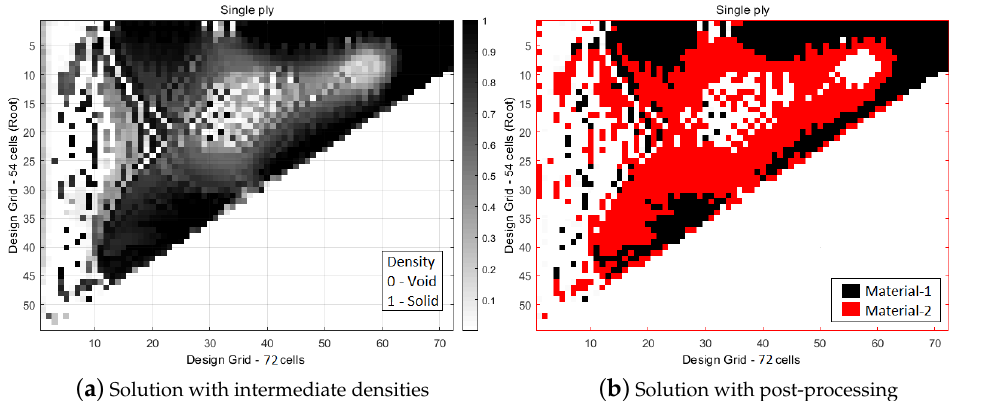
Figure 12. Topology optimization solutions of Cases 3 with and without post-processing.